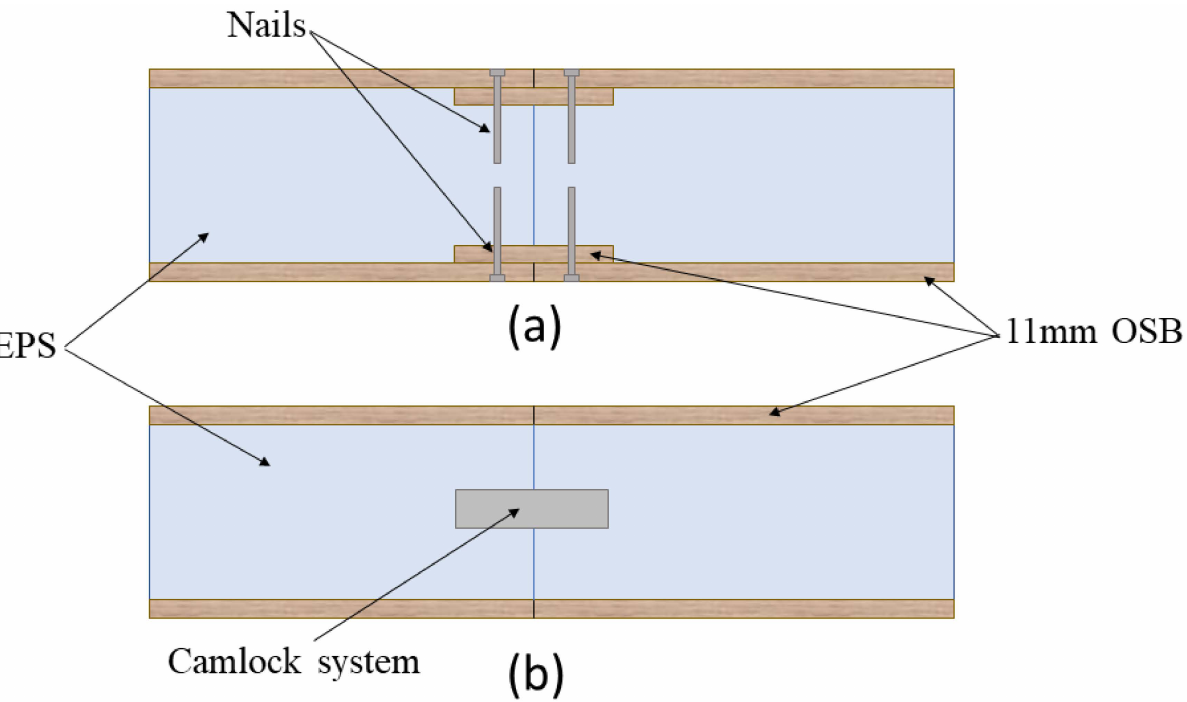
Figure 2. Top view schematics of the unit cell of the SIP wall connected by ( a ) surface spline and ( b ) embedded camlock systems.